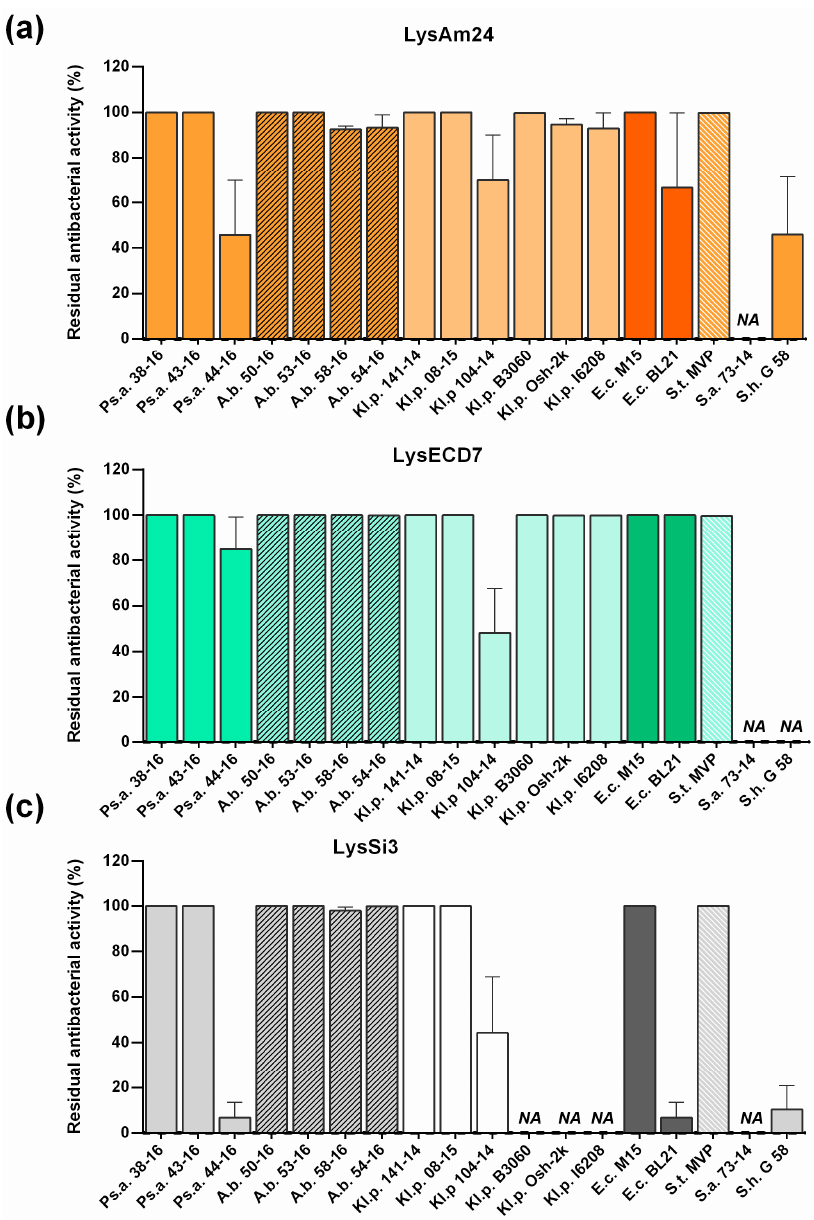
Figure 4. Endolysin activity against different strains of Gram-negative bacteria. Bacterial count (cfu/mL) was used as the method of choice for all strains: ( a ) LysAm24, ( b ) LysECD7, ( c ) LysSi3. For all experiments, the mean values are shown ( ± SEM) from three independent experiments. NA, no bactericidal activity was detected. All other data points were statistically significant compared to the untreated control culture ( p < 0.05, Mann–Whitney test).